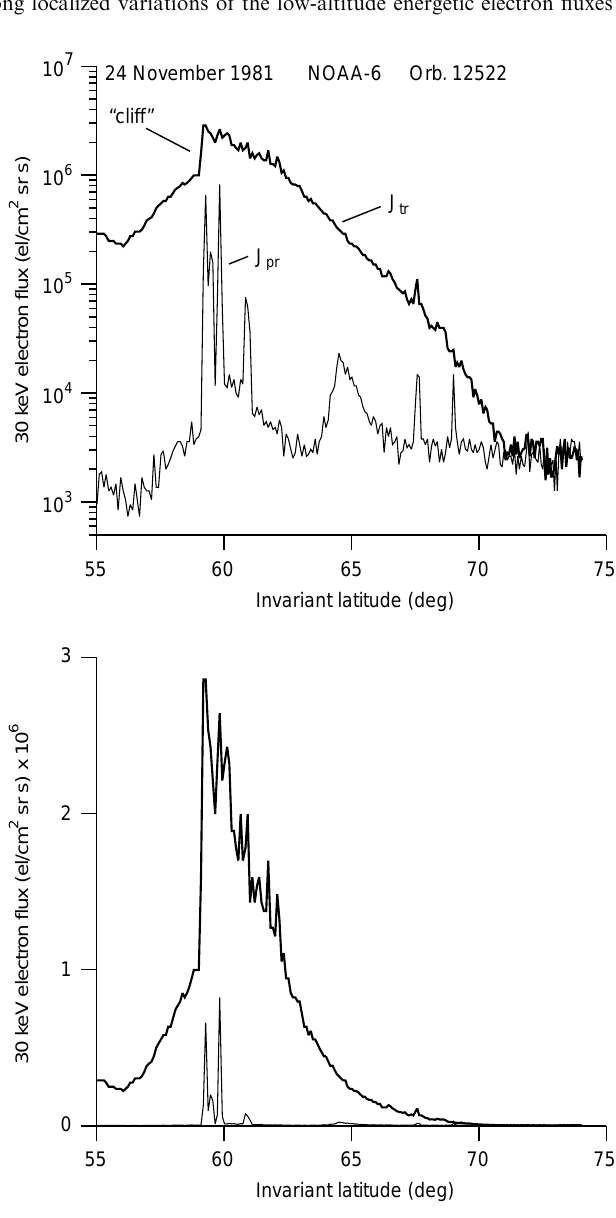
Fig. 1. Example of phenomenon studied in this study. The NOAA satellite data are shown in logarithmic ( top ) and linear ( bottom ) scales to emphasize the structure of both the precipitation burst and sharp increase in the